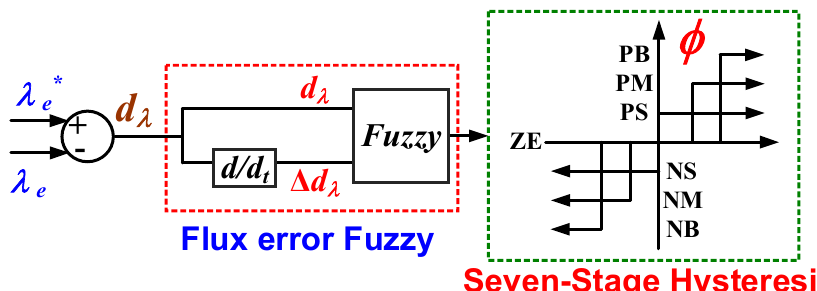
Figure 8. Flux error fuzzy controller with seven-stage hysteresis control. Table 7. MDMVV switching table.